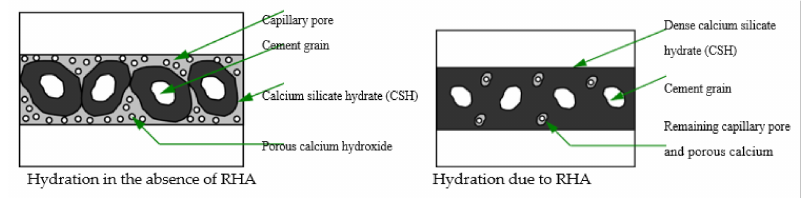
Figure 5. RHA pozzolanic behavior